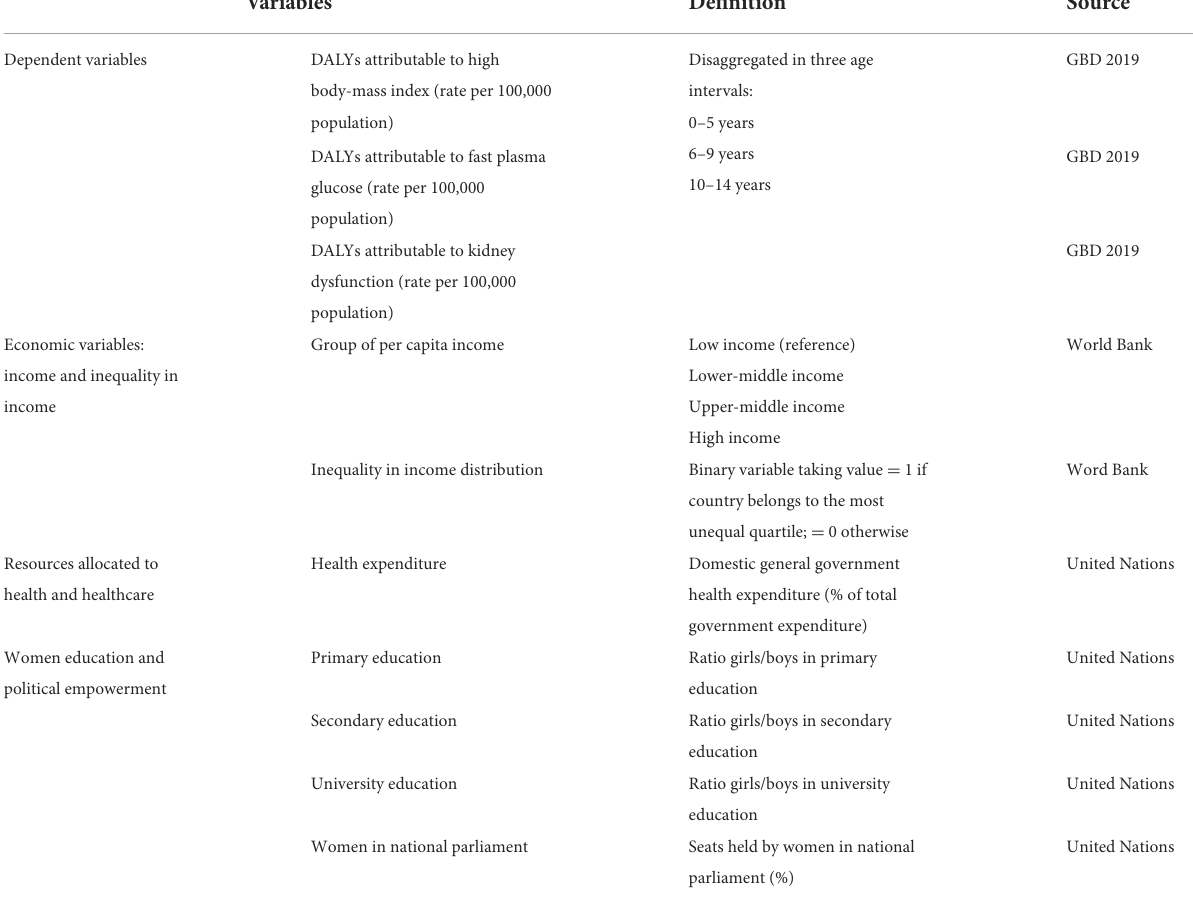
TABLE 1 Variable definitions and